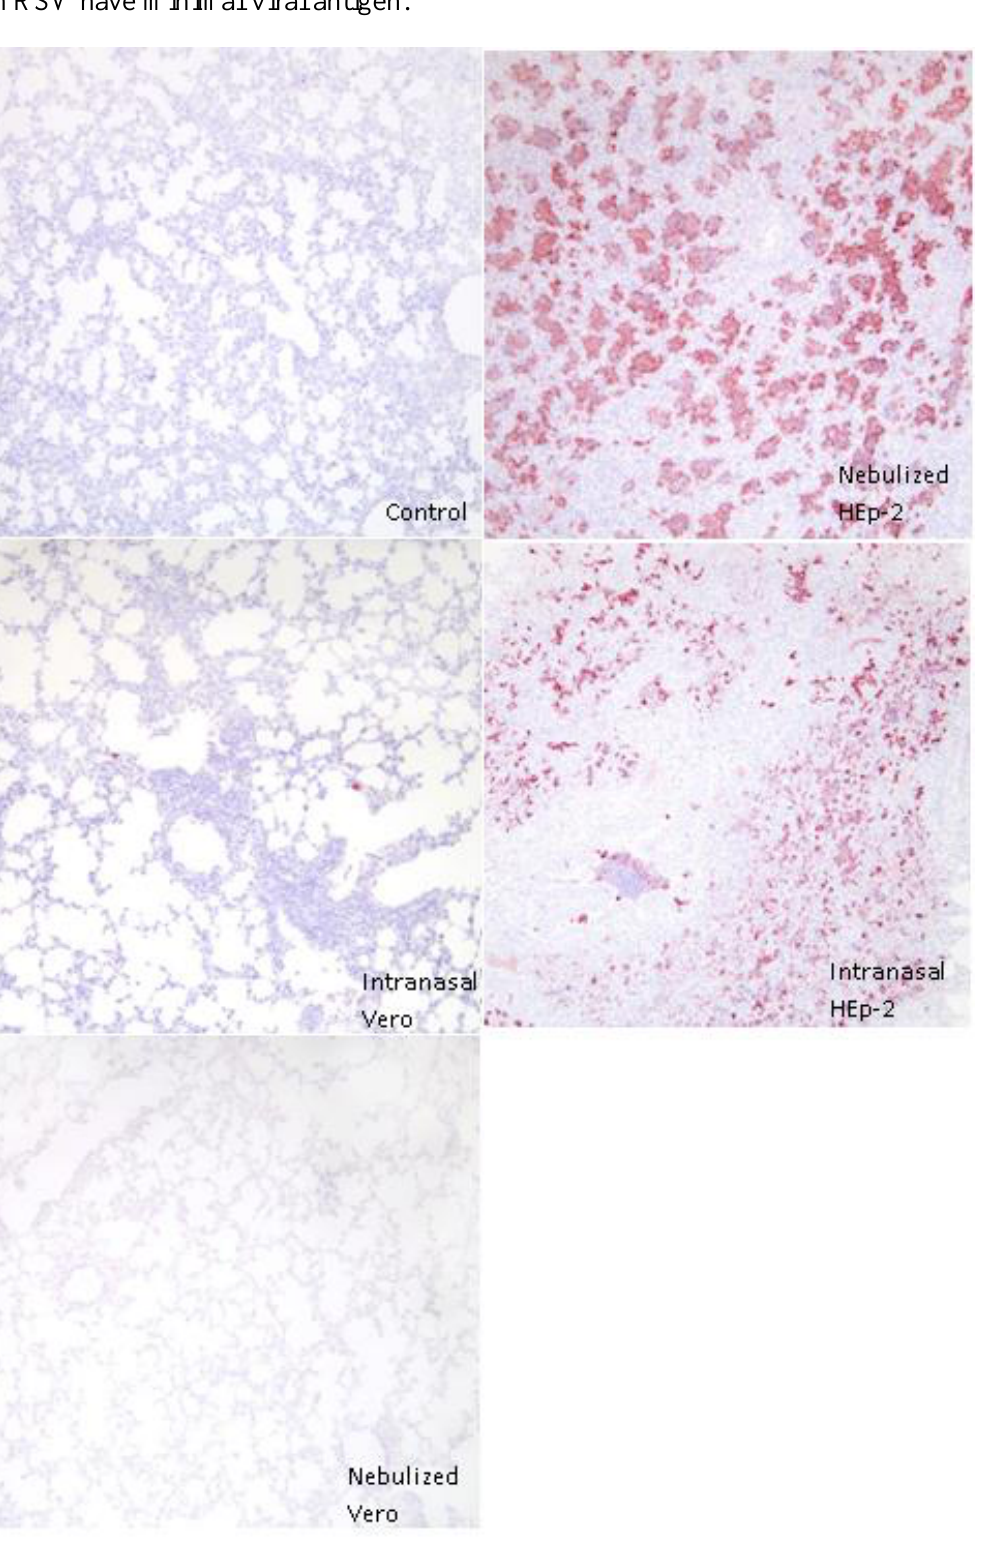
Figure 5. Immunohistochemical staining for RSV antigen. Representative immunohistochemical staining of lambs inoculated with respiratory syncytial virus (RSV), 10X magnification. Viral antigen is widely dispersed and staining is intense in lung of lambs infected with RSV grown in HEp-2 cells while lambs inoculated with Vero cell grown RSV have minimal viral